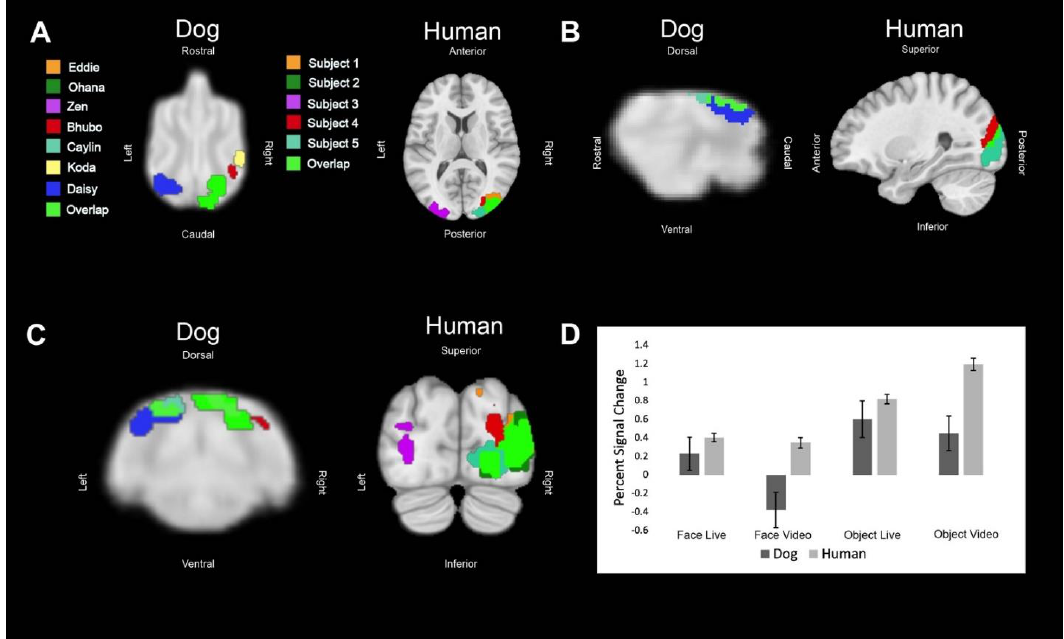
Figure 4. Definition and activations within the human lateral occipital complex and its analog in dogs. Each color represents the ROI of one dog or human or an area where the regions of interest overlapped. ( A ) Dorsal (dog) and axial (human) views of individual ROIs. ( B ) Sagittal views. ( C ) Transverse (dog) and coronal (human) views. ( D ) The bar graph shows the average percent signal change for each species for each condition relative to the implicit baseline. Error bars are the standard error.